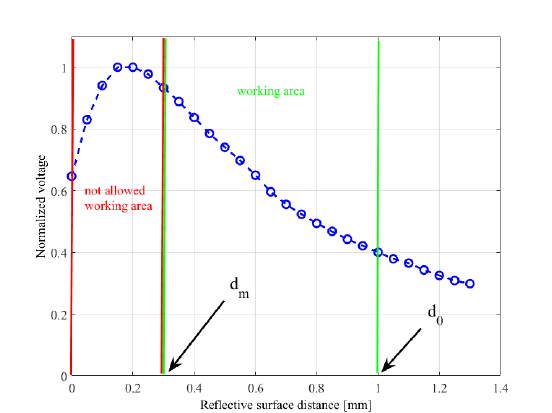
Figure 4. Characteristic for a single taxel: Normalized voltage vs. reflective surface distance.